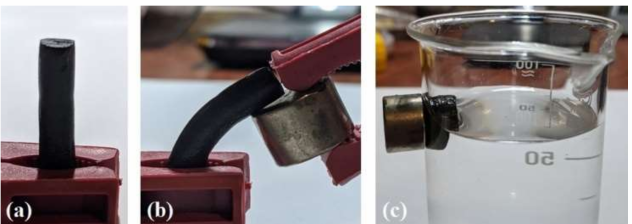
Figure 10. Demonstration of the hydrogel composite interaction with a constant magnet: ( a ) swollen sample based on SmCo5/HEMA-gr-PVP copolymer; ( b ) interaction of the sample with a constant magnet; ( c ) demonstration of removal of FMF-filled hydrogel from a liquid medium under the action of a constant magnet.